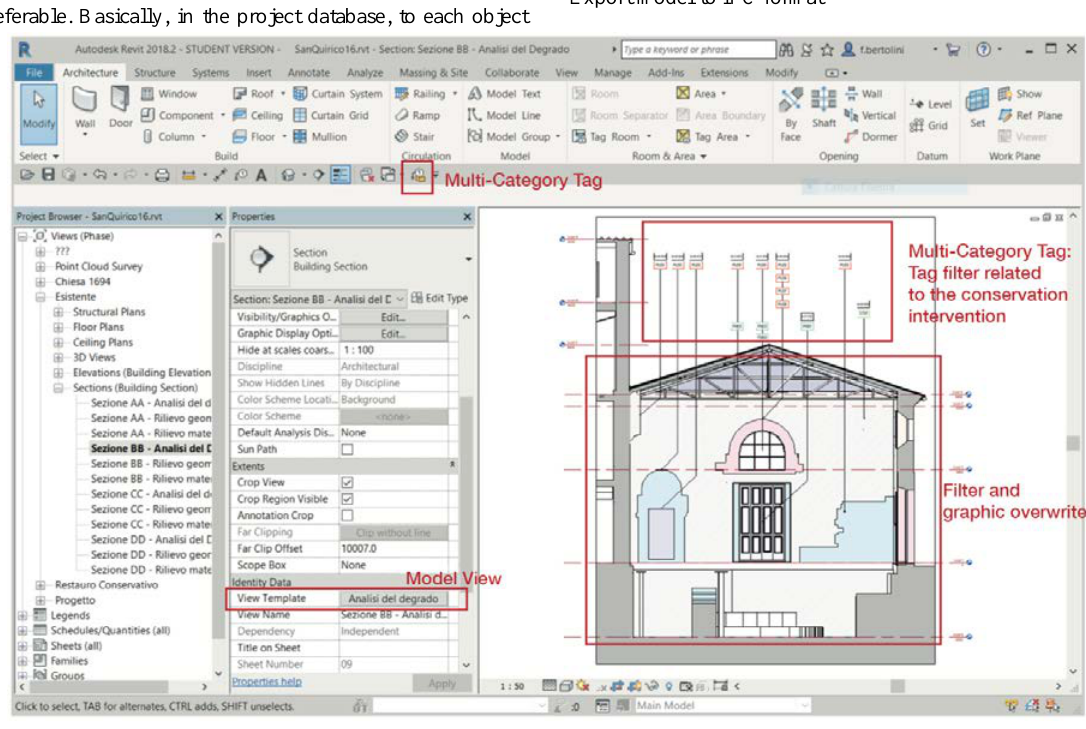
Figure 3 Multi-category tag in a model